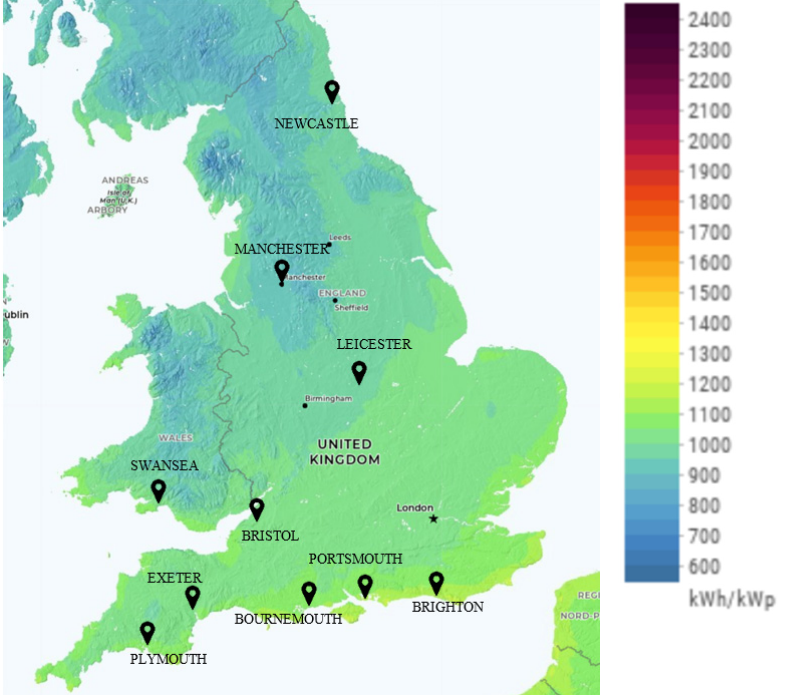
Figure 1. Solar atlas data of chosen locations [38].